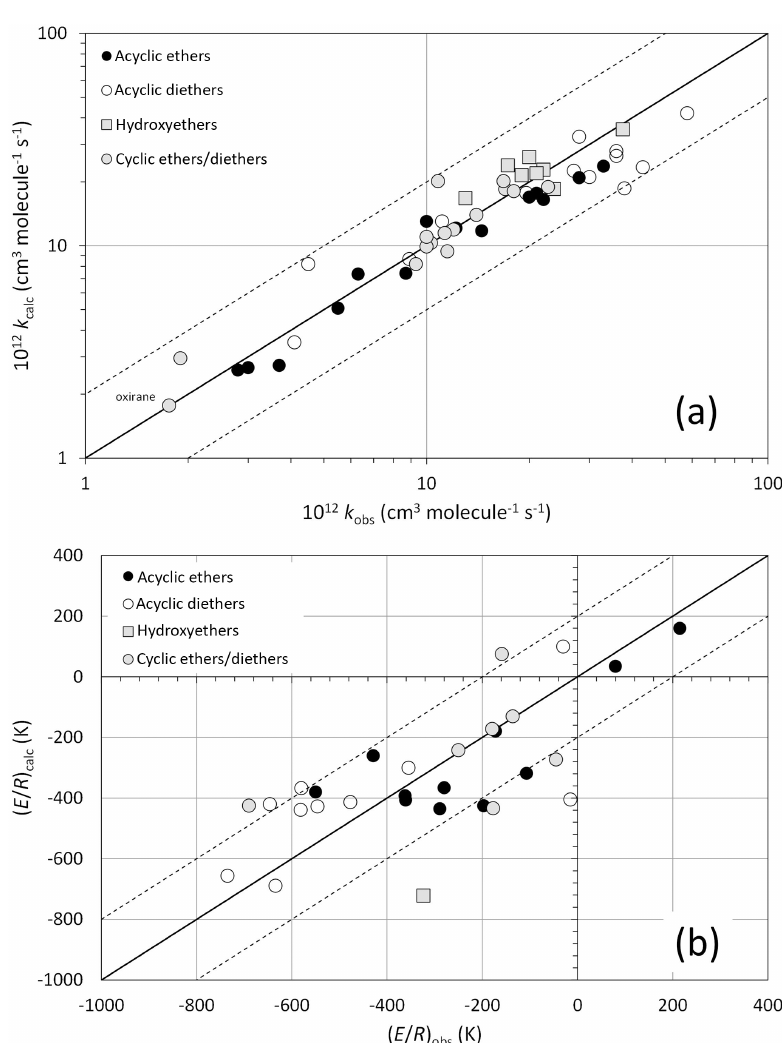
Figure 3. (a) A log–log correlation of k calc and k obs at 298K for saturated ethers, diethers and hydroxyethers (for presentation purposes, the value for oxirane has been scaled up by a factor of 20). The broken lines show the factor of 2 range (see Table S1 for identities of outliers). (b) A correlation of the temperature coefficients (E/R) calc and (E/R) obs for the same compound classes. The broken lines show the ± 200K